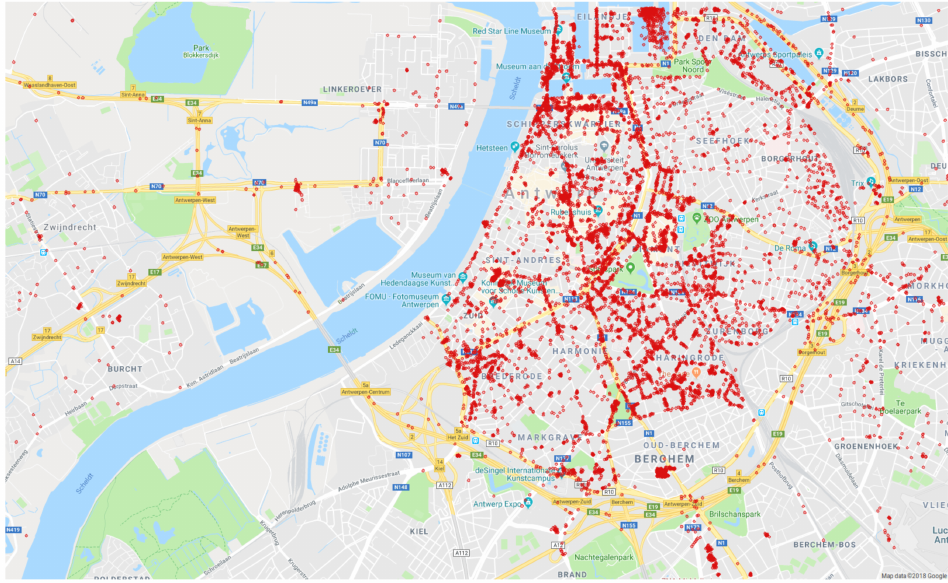
Figure 2. A map showing a random sample of used data points [46].